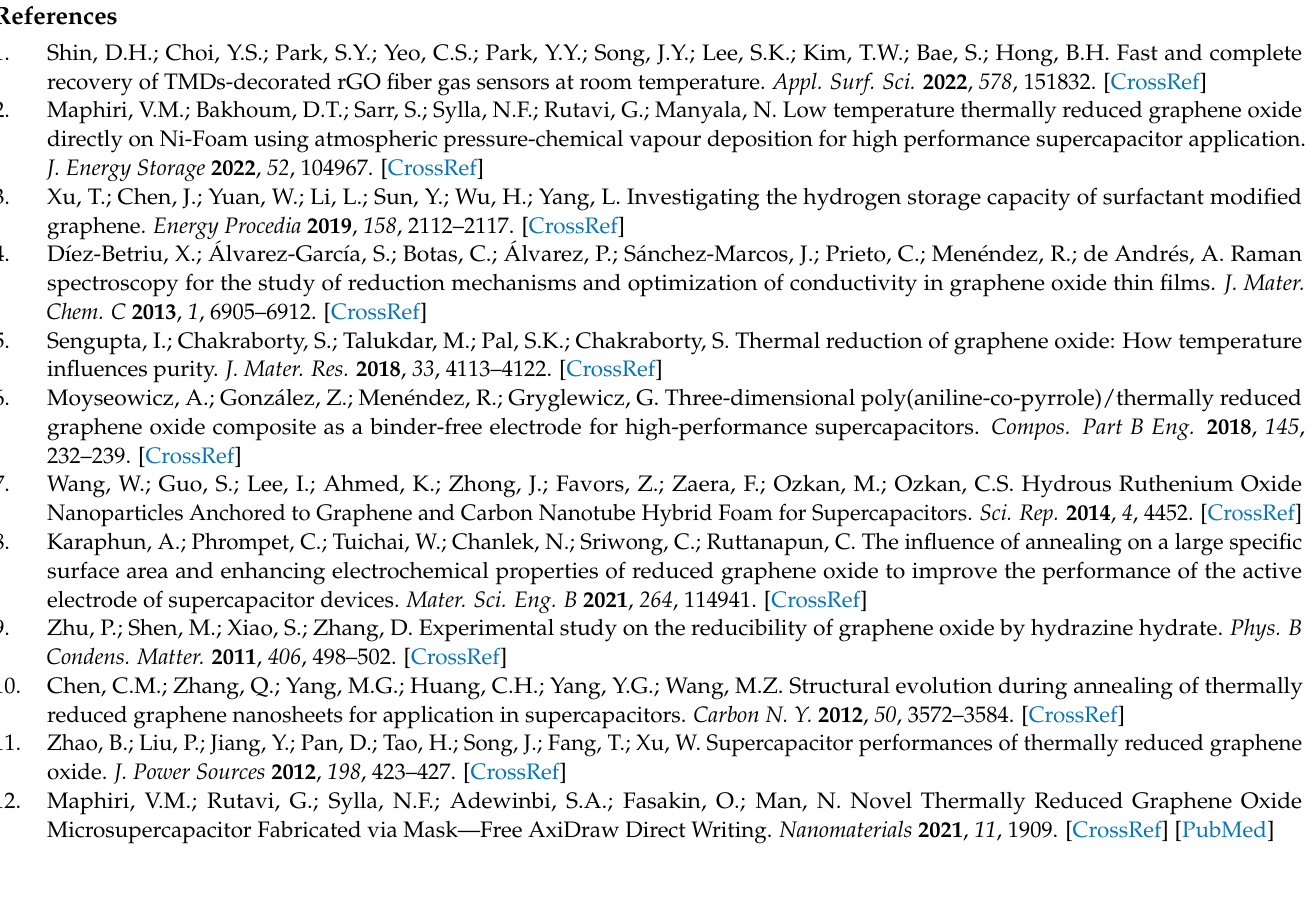
square root of scan rate, Table S5: Sample ID, maximum total capacitance, maximum EDL capacitance and maximum pseudocapacitance, Figure S13: (a)–(d) GCD curves of TRGO 200–TRGO 500, Table S6: The areal capacitance determined from the GCD curve, Figure S14: (a) Area capacitance as a function of reducing temperature at various current densities, (b)–(e) the capacitance retention and capacitance columbic efficiency of the TRGO sample and (f) EIS Nyquist plot at high frequency region, Table S7: Sample ID, resistance electrolyte plus charge transfer resistance ( R e + R ct ), Warburg coefficient ( σ w ) and ion diffusion coefficient (D), Figure S15: The frequency dependence of the Re C and Im C for (a)–(b) TRGO-200 to TRGO-500 and Figure S16: The relationship between Re Z and ω − 0.5 at low frequencies for TRGO samples